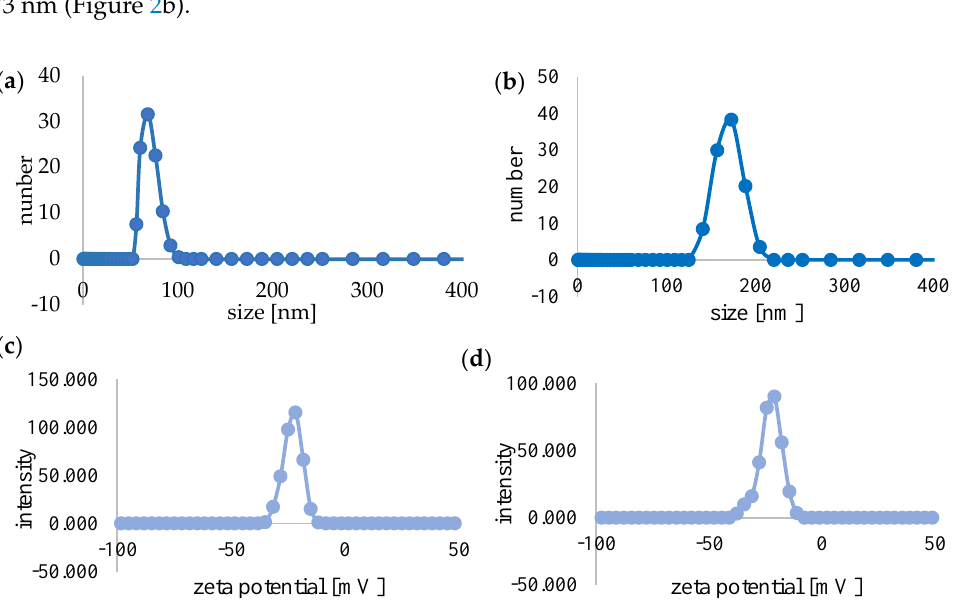
Figure 3. MT concentration in MCF-10A cells treated with C 60 , DOX and C 60 – DOX complex. The triangle marks a statistically significant difference compared with the control ( p < 0.05). The asterisk marks statistically significant difference compared with the C 60 – DOX ( p < 0.05). A lower concentration of MT-1/2 in cells treated with both C 60 and DOX was found compared to the control sample. However, a much higher concentration of MT-1/2 was recorded in the case of cells treated by C 60 – DOX complexes. MT concentration in cells treated with complexes increased almost 3-fold compared to the control sample. The con- centration of MT was also higher in the sample with cells treated with C 60 – DOX complexes than in cells supplemented with C 60 or free DOX. 3.3. The Effect of C 60 – DOX Complexes on SOD Concentration and Activity in MCF-10A Cells SOD1 levels in MCF-10A cells treated with C 60 , DOX, and C 60 – DOX were determined and converted to total protein concentration in cell lysates (Figure 4).